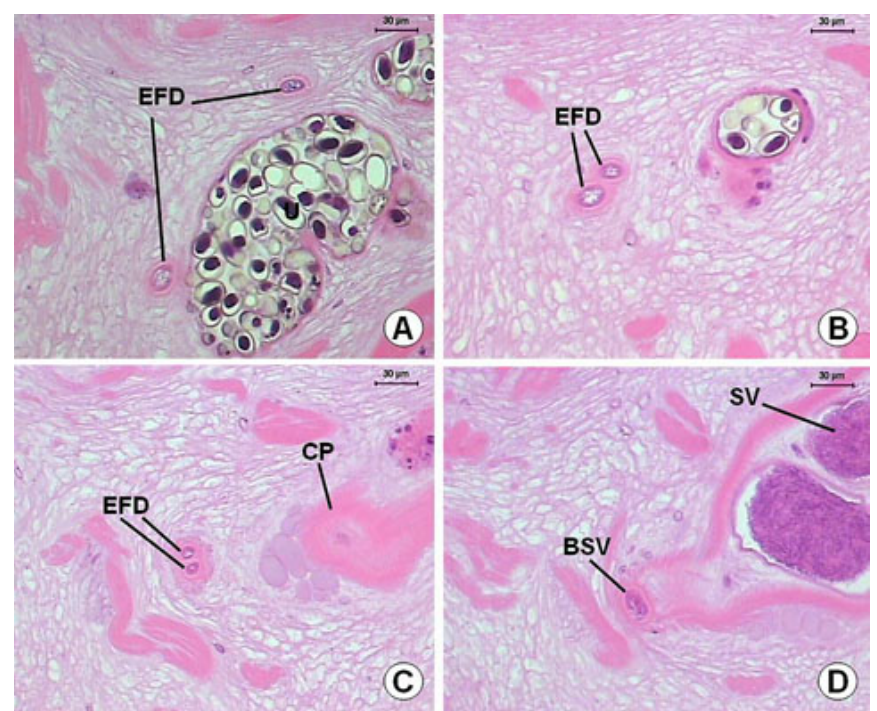
Figure 22. A-C) Detail of the Sticholecitha efferent duct. EFD – efferent duct, CP – cirrus pouch, BSV – beginning of the seminal vesicle inside the cirrus pouch, SV – Seminal vesicle. HE.